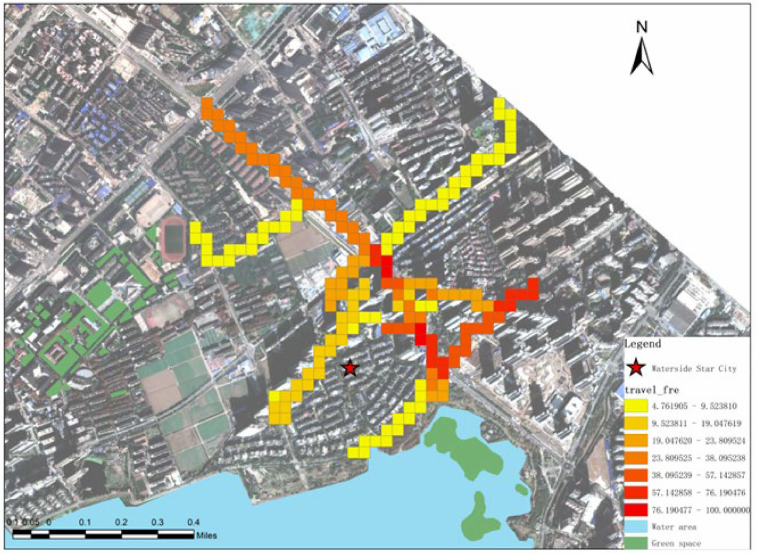
Figure 10. Waterside Star City residents’ travel